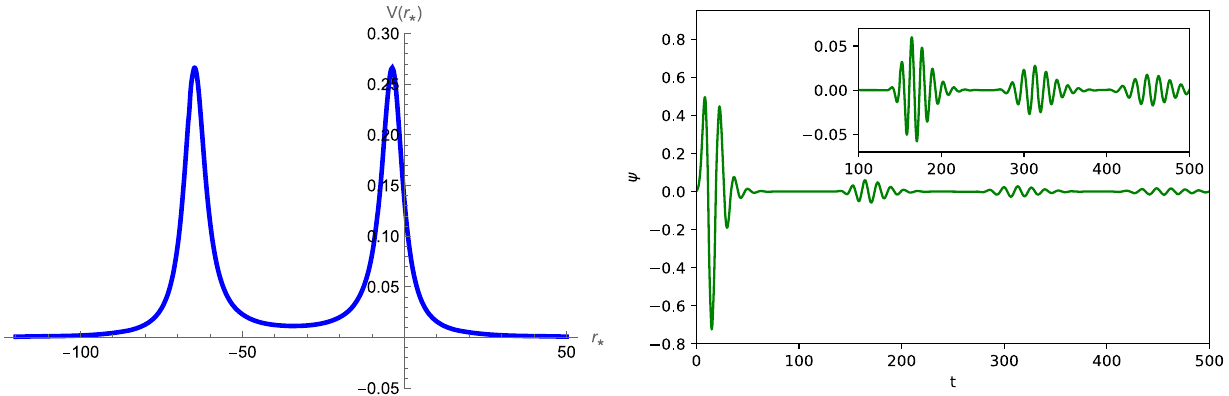
Fig. 6 The effective potential and gravitational wave echoes of the scalar field perturbation to black bounces in a cloud of strings with M = 0 . 5 , l = 1 , L = 0 . 1 , a = 1 . 12